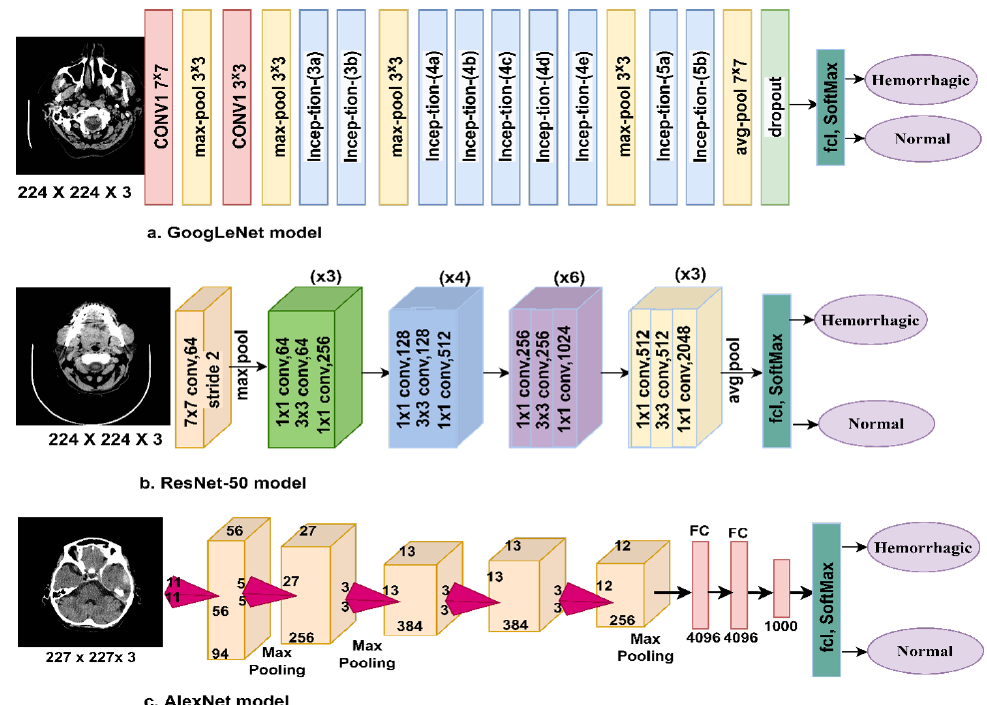
Figure 4. Infrastructure framework for CNN models for evaluating CT images for the diagnosis of cerebral hemorrhage